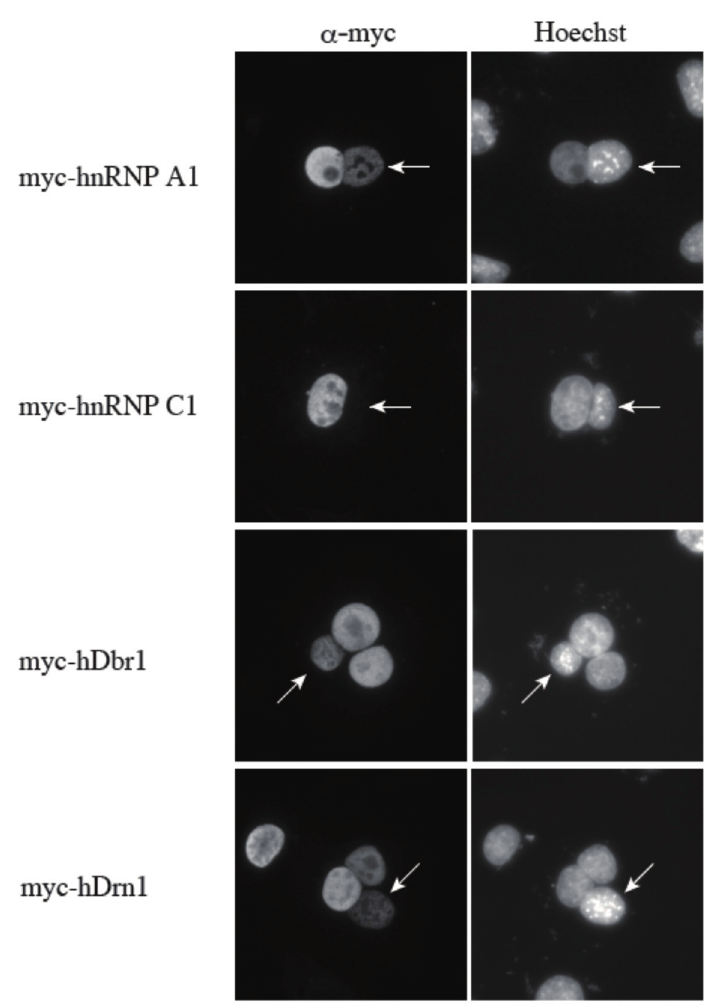
Figure 7. The hDrn1 protein shuttles between the nucleus and the cytoplasm as hDbr1. Expression vectors encoding hnRNP A1, C1, hDbr1 and hDrn1 with myc-tag were transfected into HeLa cells. After expression of the transfected cDNAs, the cells were fused using PEG with mouse NIH3T3 cells to form heterokaryons and incubated in culture medium containing 100 μ g/mL cycloheximide for two hours. The heterokaryon cells were then fixed and stained for immunofluorescence microscopy with anti-myc tag antibody (panel FITC) to localize the proteins, and Hoechst 33342 (panel Hoechst), which distinguishes the human and mouse nuclei within the heterokaryon. The arrows indicate the mouse